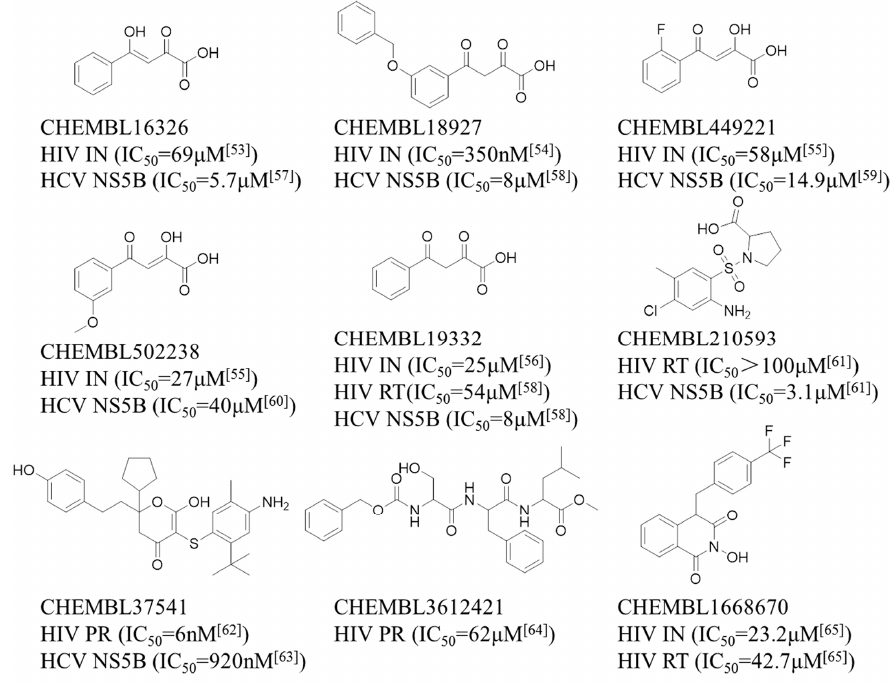
Figure 8. The structure and bioactivity data of the nine selected compounds.